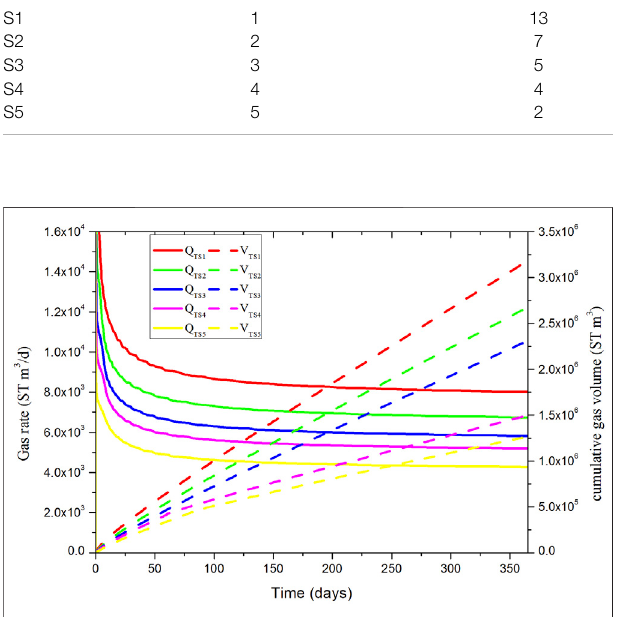
FIGURE12| Time-varyinggasproductionrate( Q TS )andcumulativegas production ( V TS ) in case of different fracture spacings.